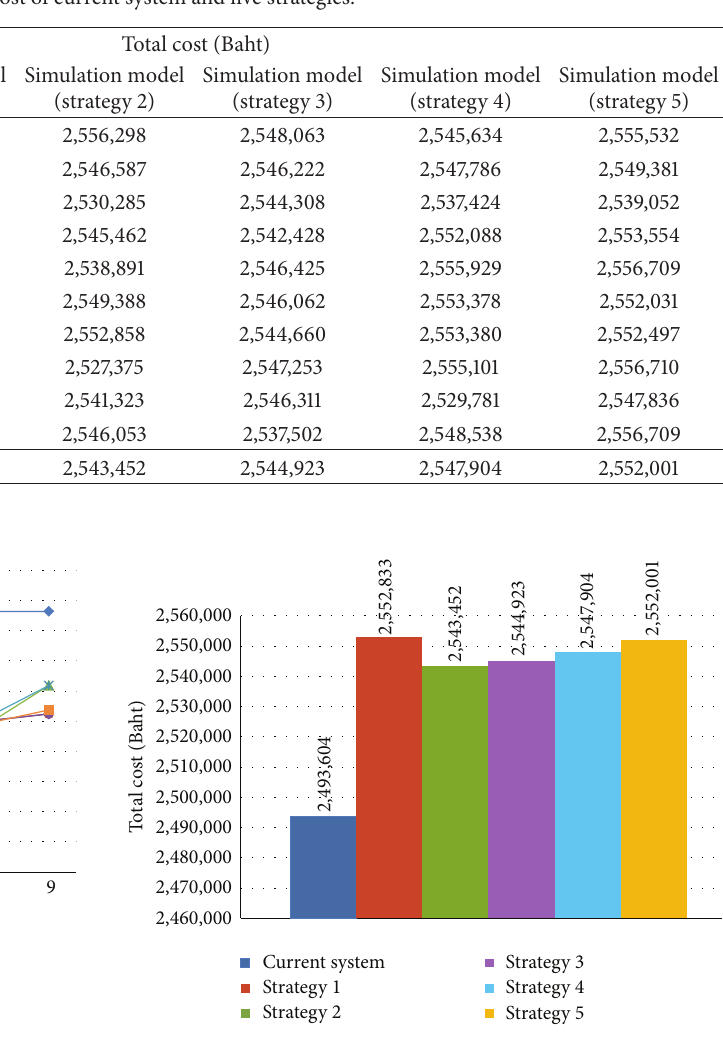
Figure 6: Comparison of total cost of current system and five strat-